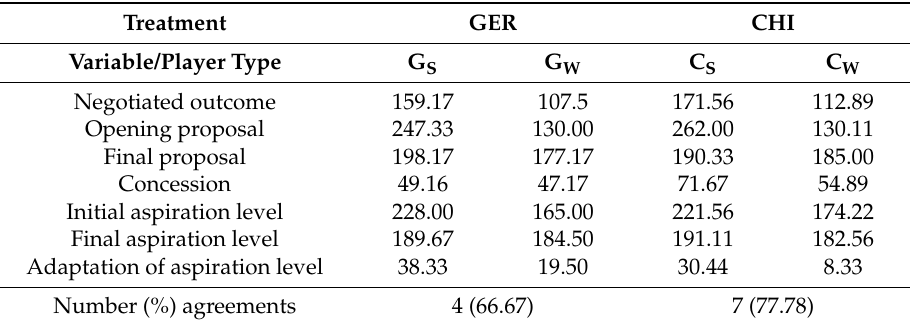
Table 2. Descriptive statistics of the